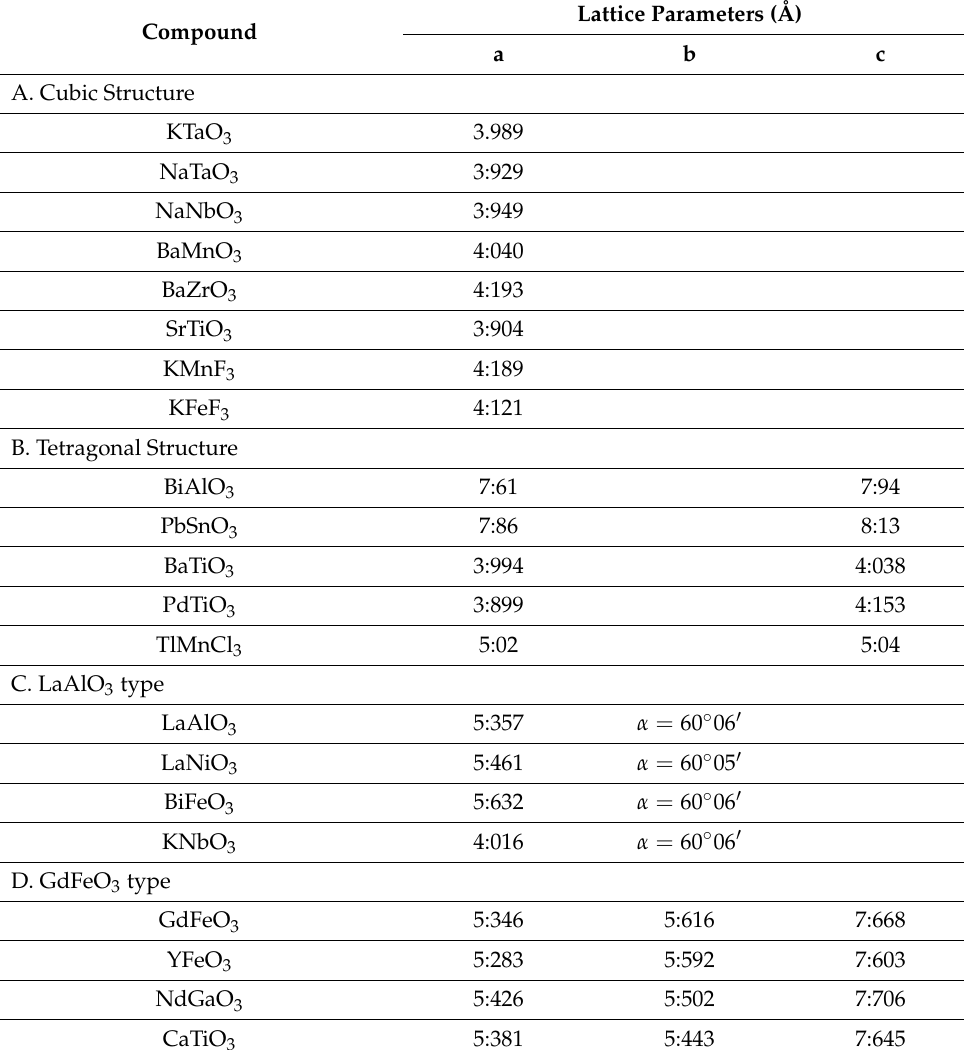
Table 1. Typical example of perovskite oxides, where the perovskite oxides have mostly grown as rhombohedral